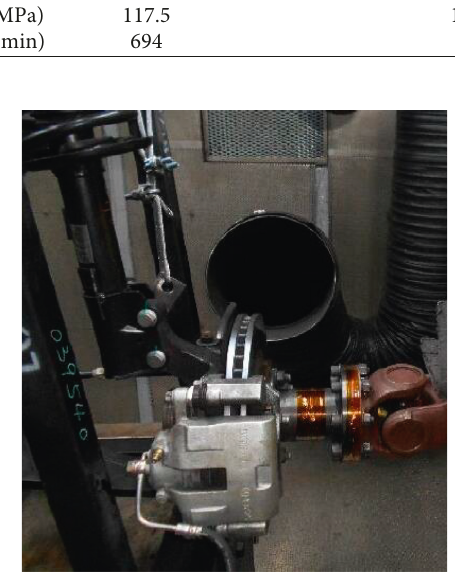
Figure 16: Configuration of the brake dynamometer test.